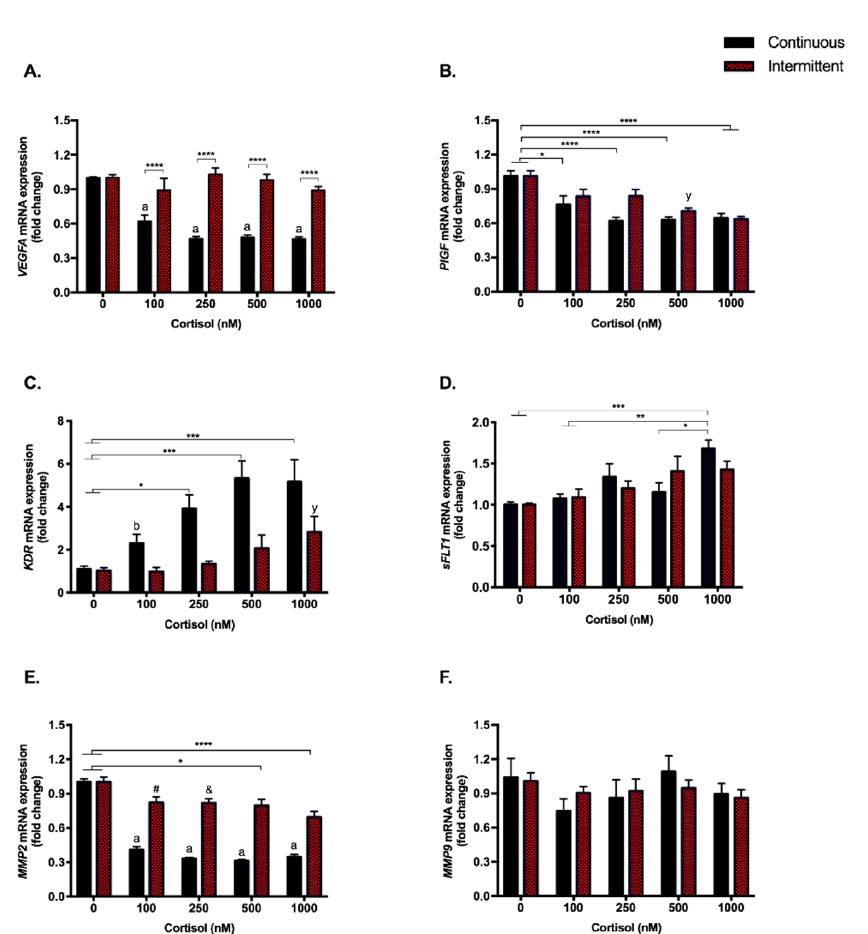
Figure 4. Angiogenic genes–gene expression. RT-qPCR of VEGFA ( A ), PlGF ( B ), KDR (VEGFR-2) ( C ), sFLT1 (soluble VEGFR-1) ( D ), MMP2 ( E ), and MMP9 ( F ) in SGHPL-4 cells treated with continuous or intermittent exposure to cortisol (100, 250, 500, 1000 nM) and vehicle (0 nM) in the medium. Data were compared by two-way ANOVA with Tukey multiple comparisons test. Interaction between (continuous or intermittent) exposure to cortisol and cortisol dose was found for VEGFA ( p < 0.0001), and MMP2 ( p < 0.0001). Data are presented as mean ± SEM. * p < 0.05; ** p < 0.01; *** p < 0.001; **** p < 0.0001; #, p = 0.0674; &, p = 0.0549; for continuous exposure: b, p < 0.05 and a, p < 0.0001 vs. control; for intermittent exposure: y, p < 0.05 vs. control. VEGFA , Vascular endothelial growth factor A; PlGF , Placental growth factor; KDR (VEGFR-2), Vascular endothelial growth factor receptor 2; sFLT1 (soluble VEGFR-1), soluble Vascular endothelial growth factor receptor 1; MMP2 , Matrix metalloproteinase-2; MMP9 , Matrix metalloproteinase-9. Cell treatment was repeated at least three times.